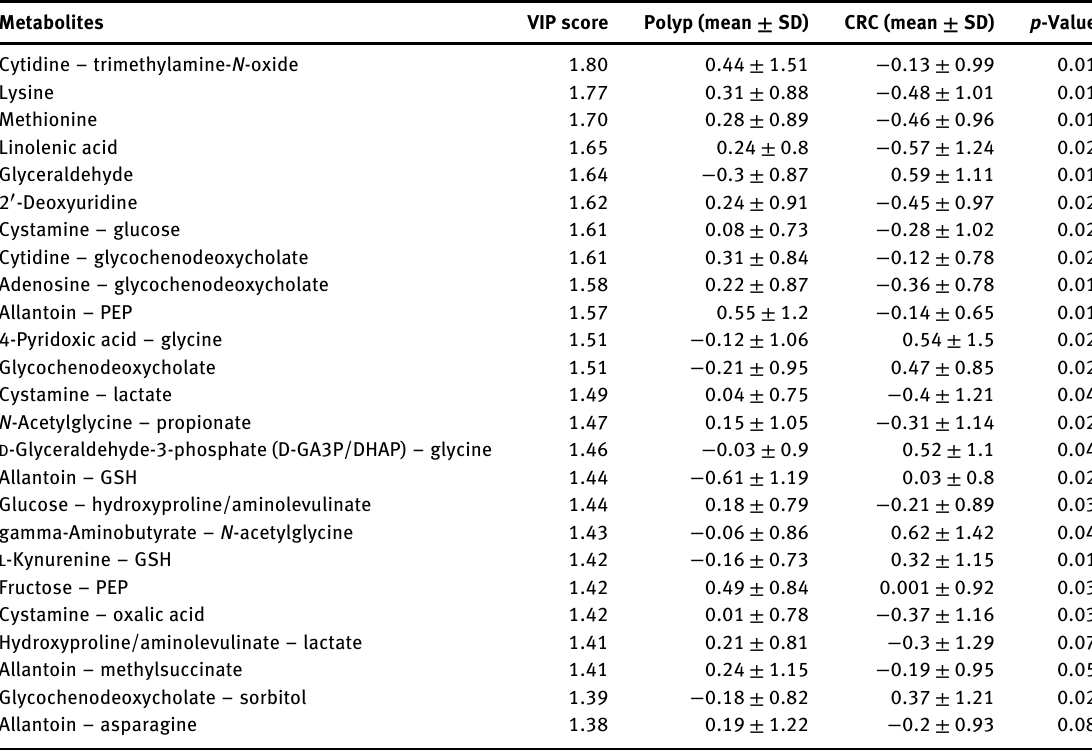
Table 3: Top 25 relevant variable (according to the VIP score) for the PLS-DA model on the enriched dataset between CRC and polyp